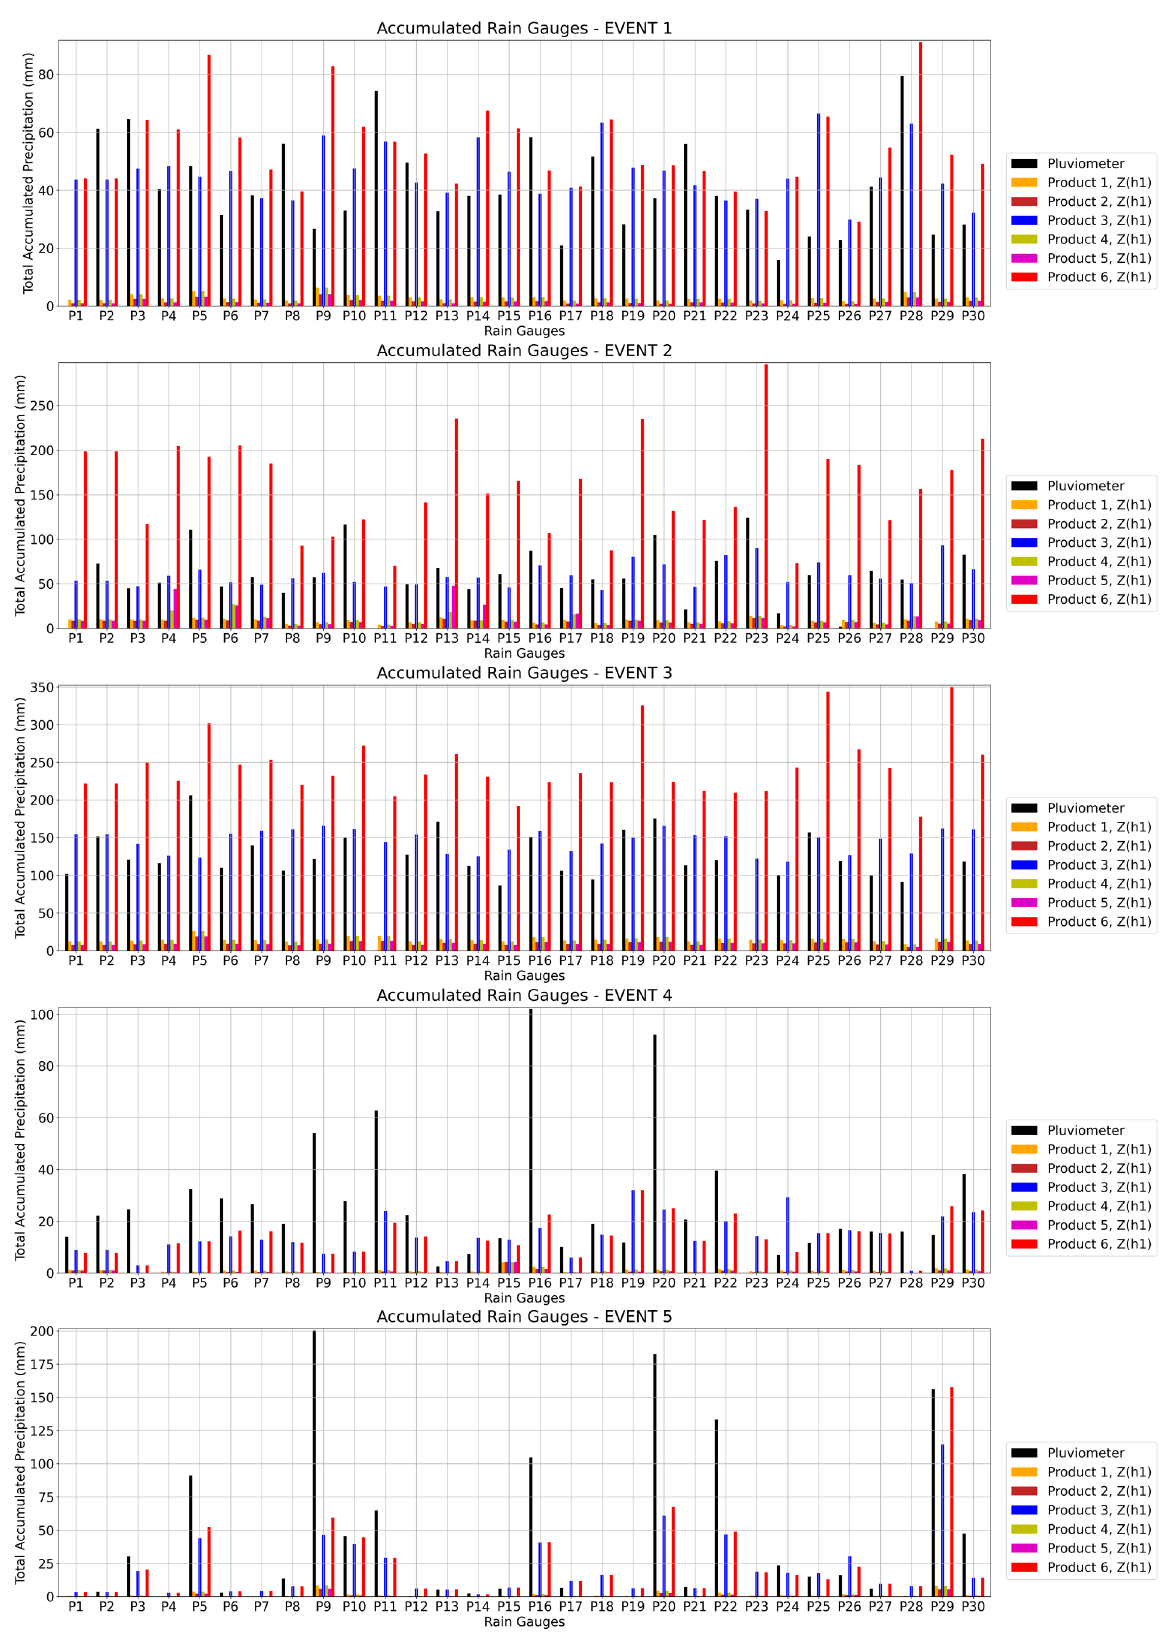
Figure 4. Total accumulated precipitation comparisons for Events 1, 2, 3, 4, and 5 between rain gauge results and Guaratiba’s six S-band radar products using Z h 1 at radar pixels where rain gauges are